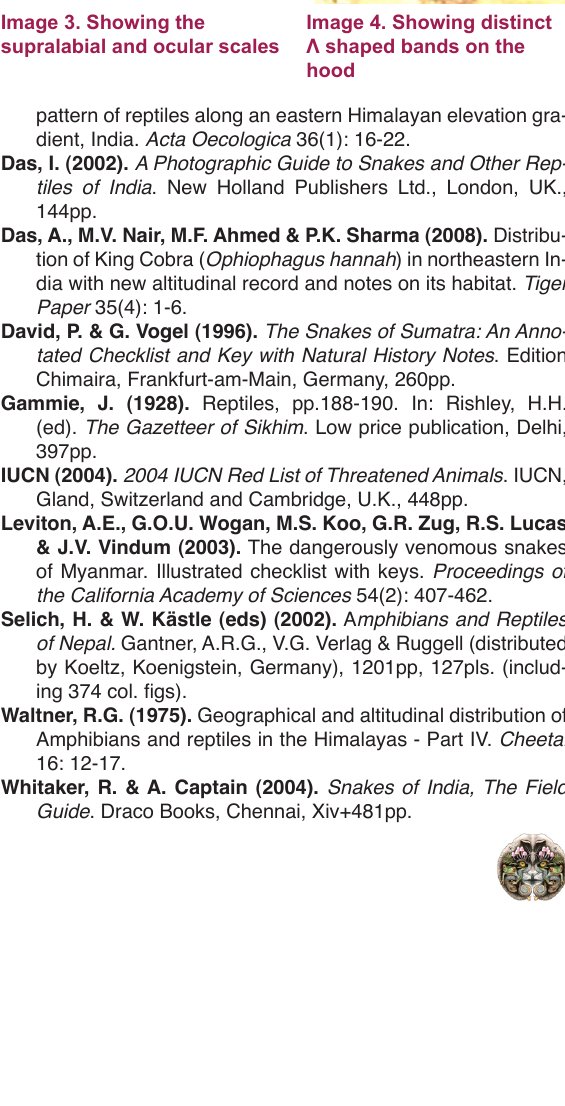
Image 2. Showing the parietal and temporal scales